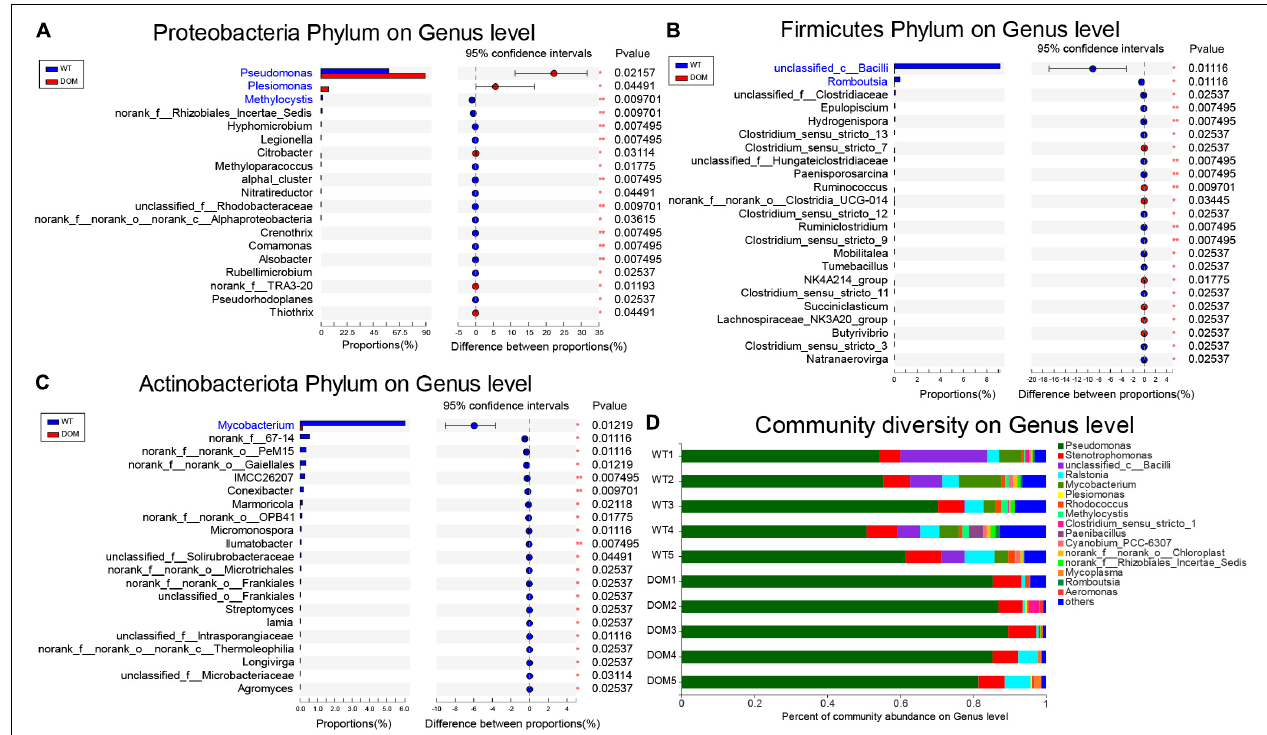
FIGURE 6 | Microbial comparison and interaction analysis at genus level in A. grunniens intestine domesticated with compound feed. (A–C) Differentially colonized microbial communities at genus level of (A) phylum Proteobacteria; (B) phylum Firmicutes; and (C) phylum Actinobacteriota. (D) Community diversity at the genus